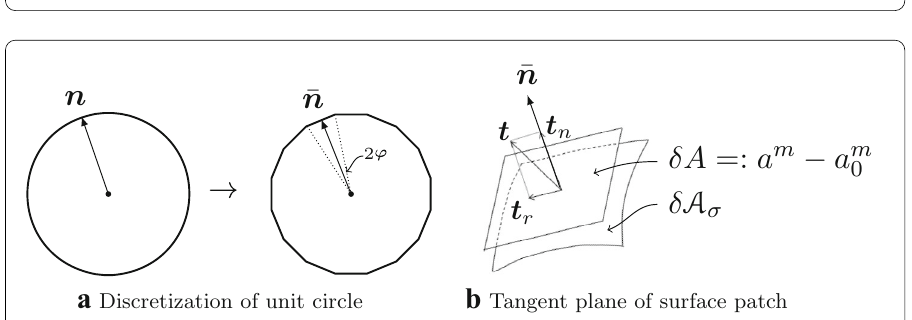
Fig. 2 Imperfect interface between grains comprising interphase region with displacement discontinuity (and traction continuity) across it: a SCH treatment of grain interfacing with matrix, and b idealized grain/grain interface reconciled with SCH description as mobilized volume of interface associated with discretized particle surface (see also Fig. 3)